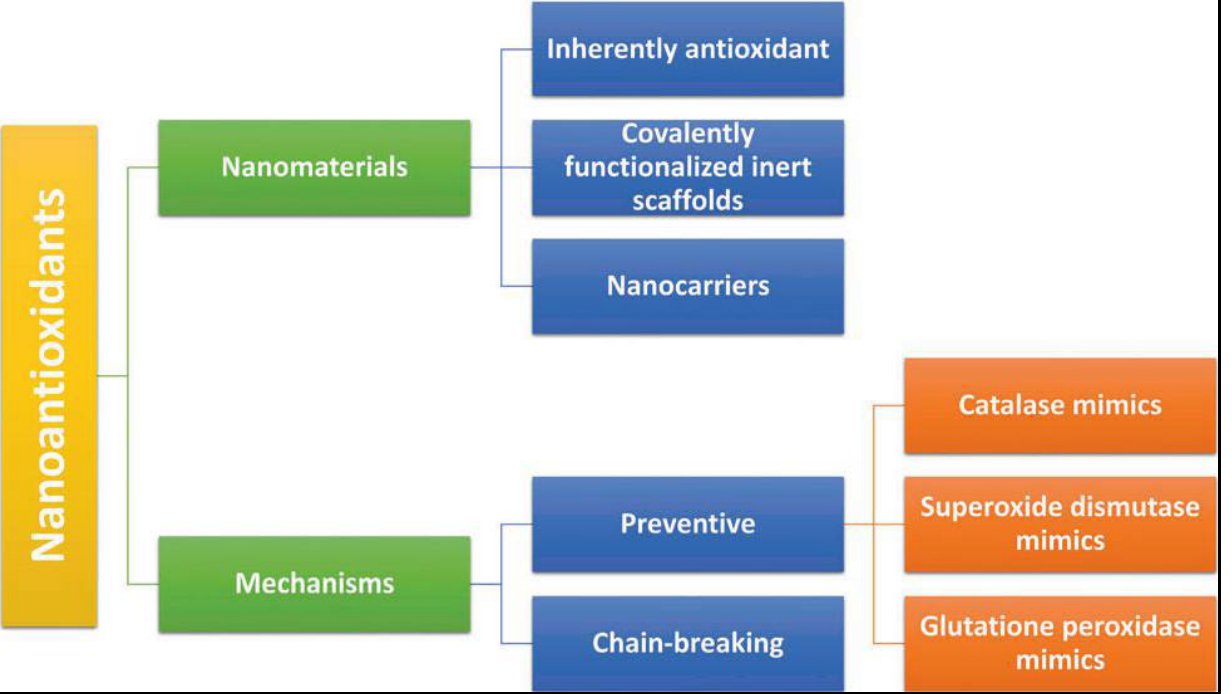
Figure 4. System for Classifying Nanoantioxidants Based on Structural and Mode of Action.